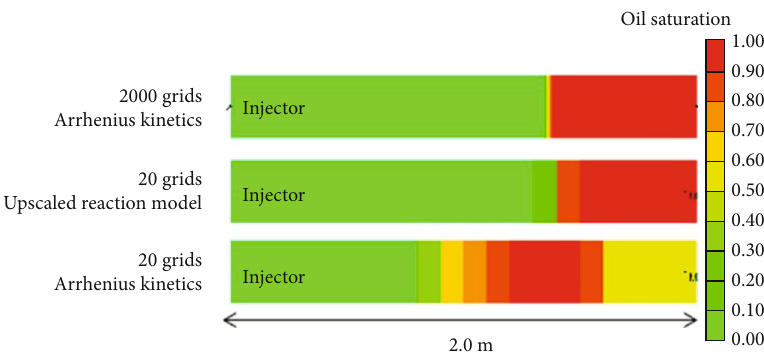
Figure 16: Oil saturation pro fi le for 2.0m length 1D ISC simulation with Arrhenius kinetics and 2000 grids, upscaled reaction model and 20 grids, and Arrhenius kinetics and 20 grids (inject from left, produce from right).